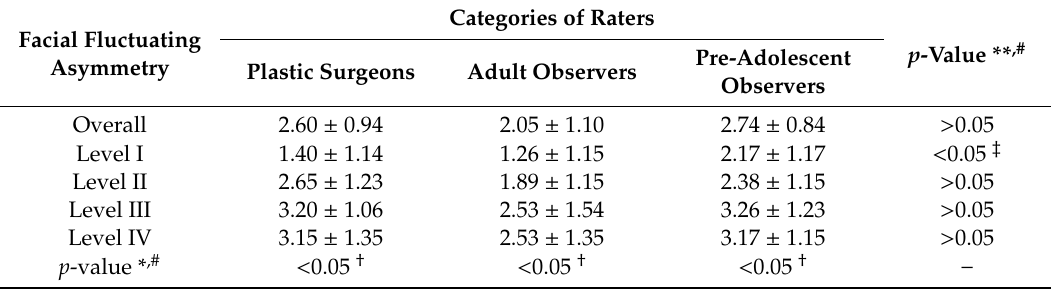
Table 2. Panel assessment of various levels of facial fluctuating asymmetry using the facial symmetry / asymmetry grading system.